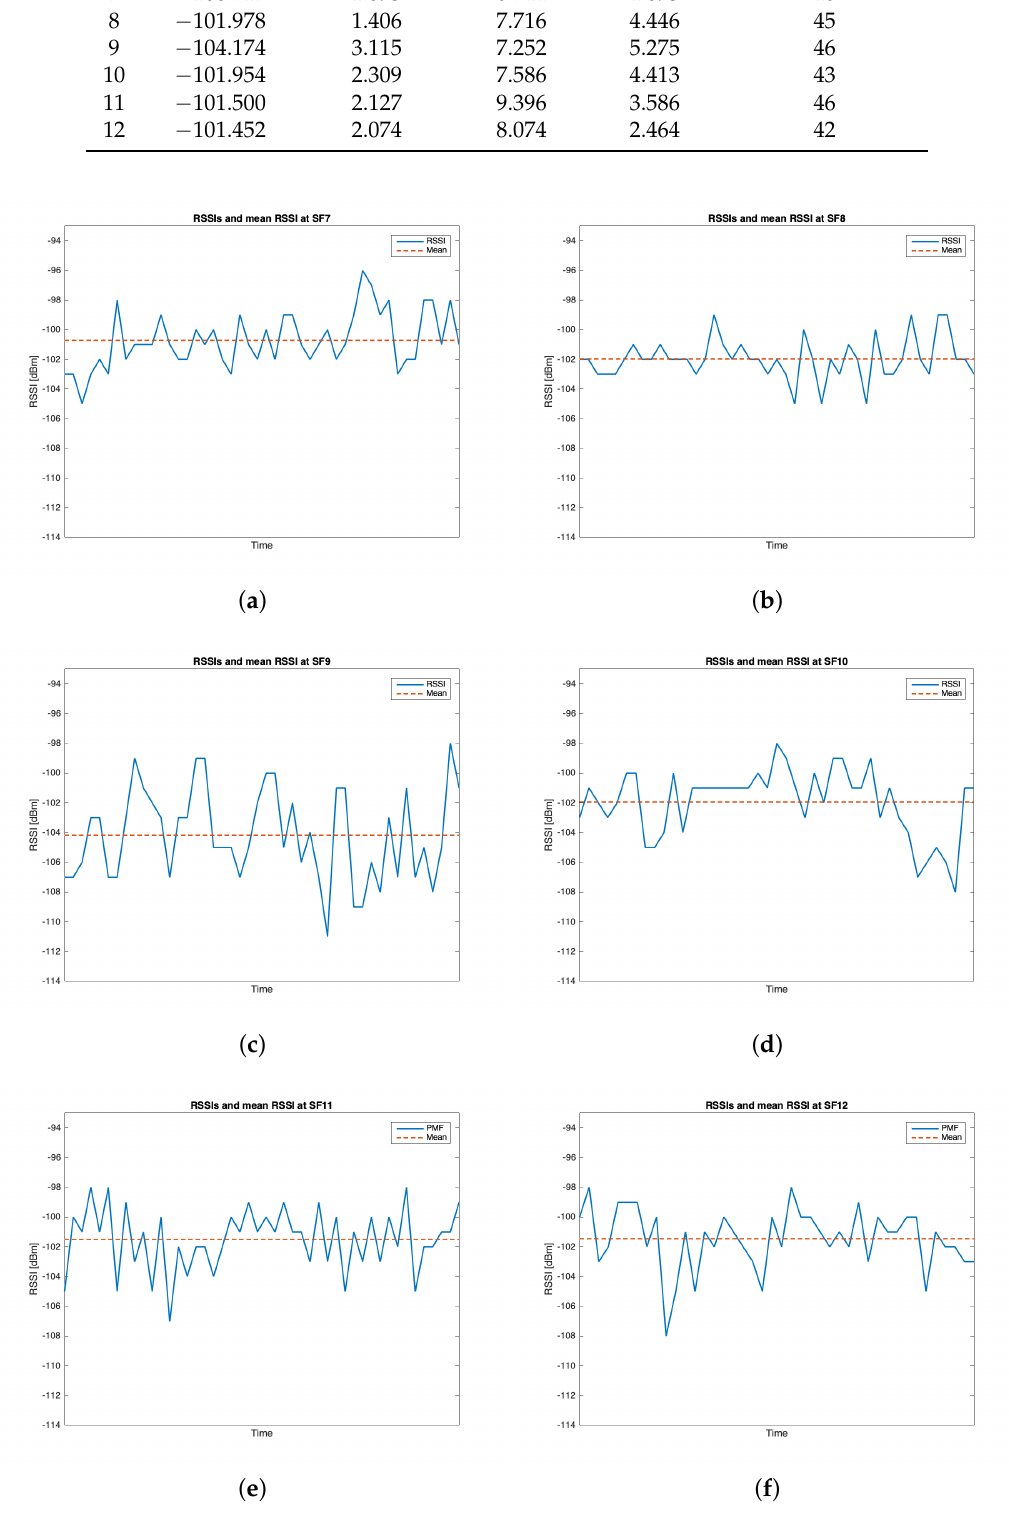
Figure 15. Group #2 RSSIs temporal trend: ( a ) SF = 7; ( b ) SF = 8; ( c ) SF = 9; ( d ) SF = 10; ( e ) SF = 11; ( f ) SF =